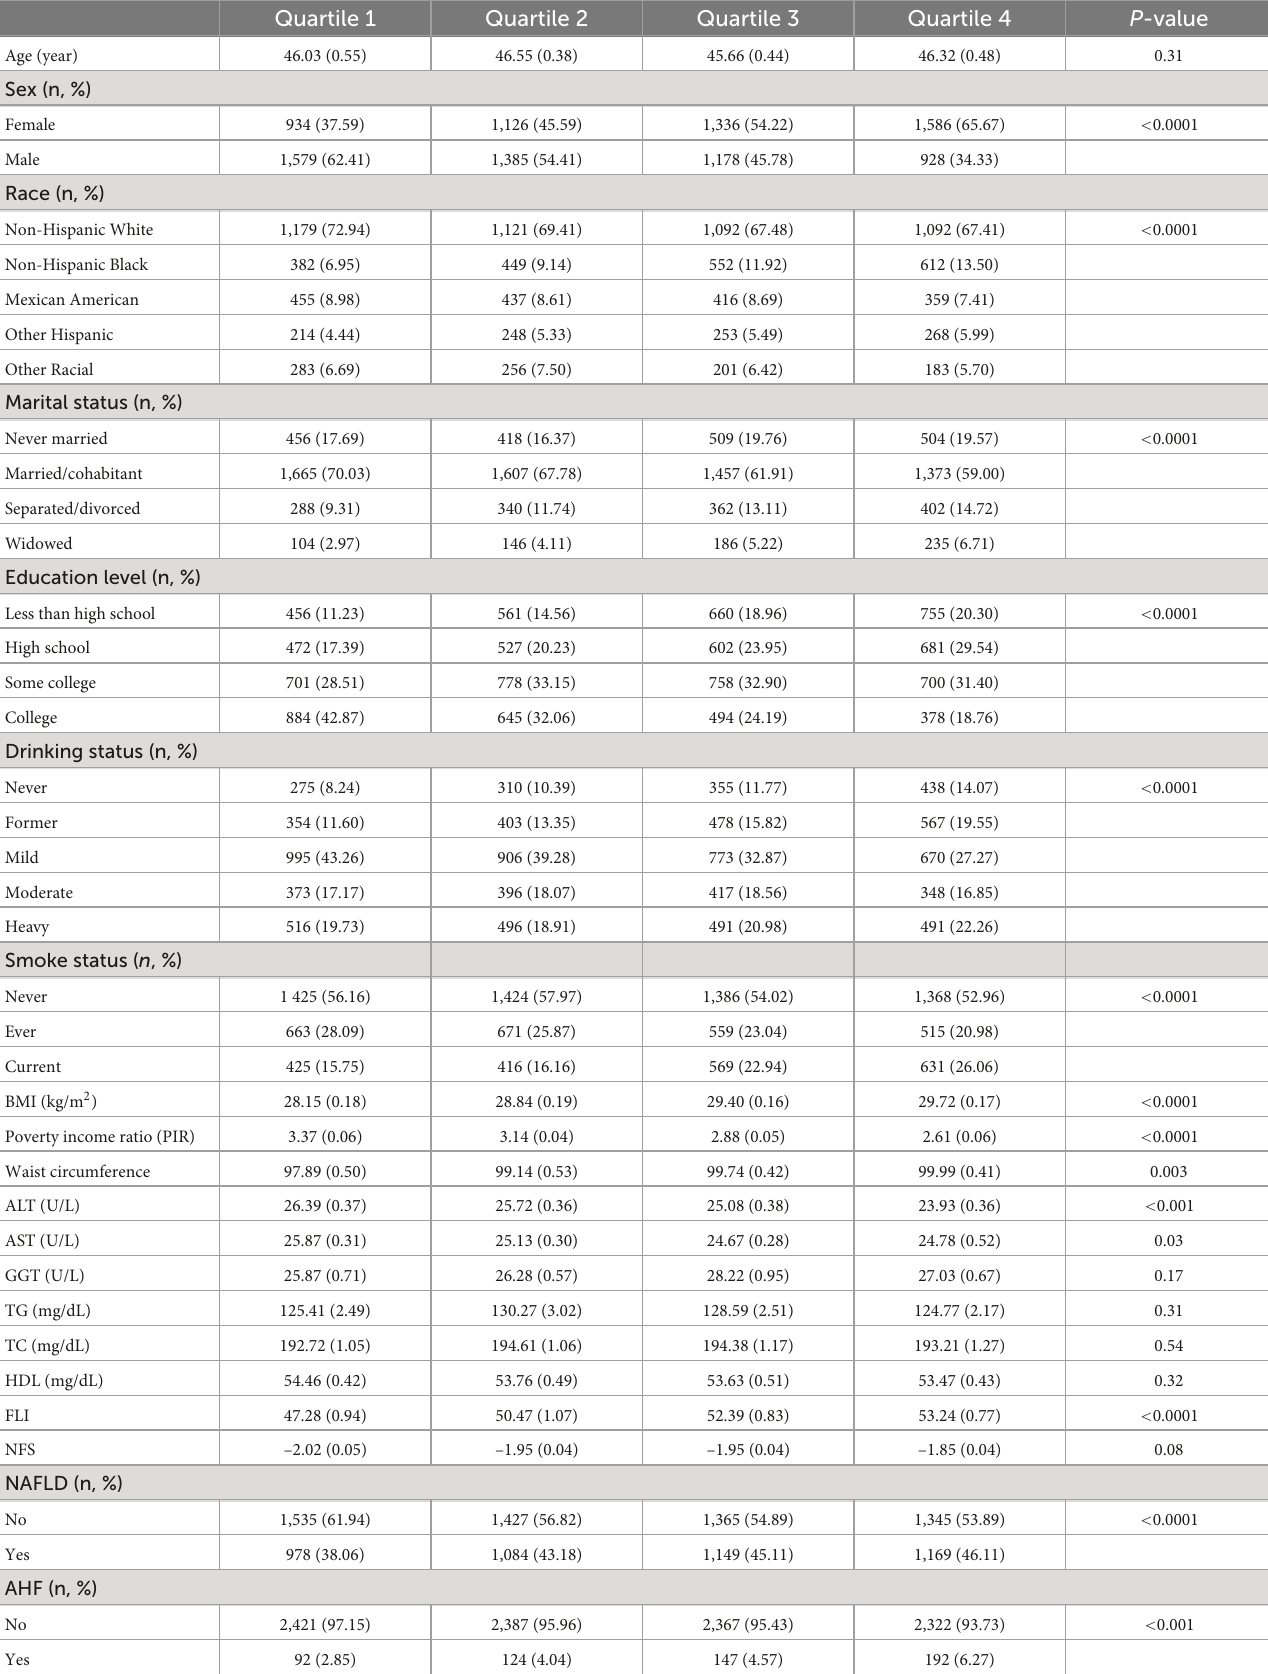
TABLE 1 Characteristics of participants in the 2005–2016 continuous National Health and Nutrition Examination Survey